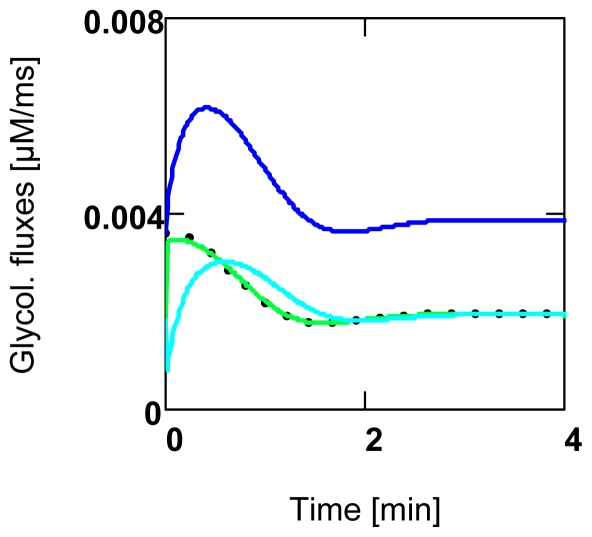
Behaviour of in series fluxes of glycolysis after a twofold increase (f = 2.0) of LGKmax · (black dots) JGK; (green) JAld; (cyan) JTi; (blue) JGa. At steady state JGa = 2 JGK; SIMGLY.